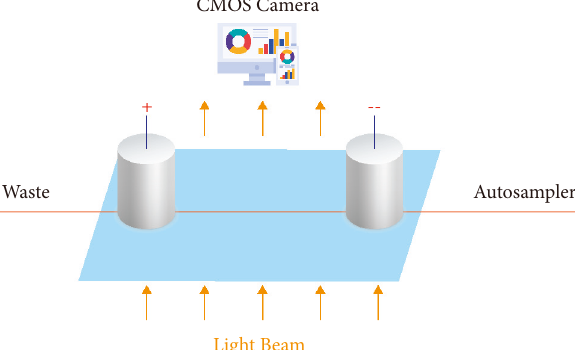
Figure 1: Schematic diagram of full-column imaging capillary isoelectric focusing electrophoresis